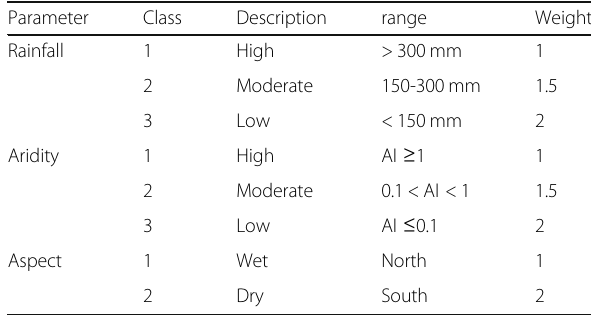
Table 4 Assigned weighing indices for various parameters used for assessment of Climate quality (Kosmas et al. 1999; Vieira et al.